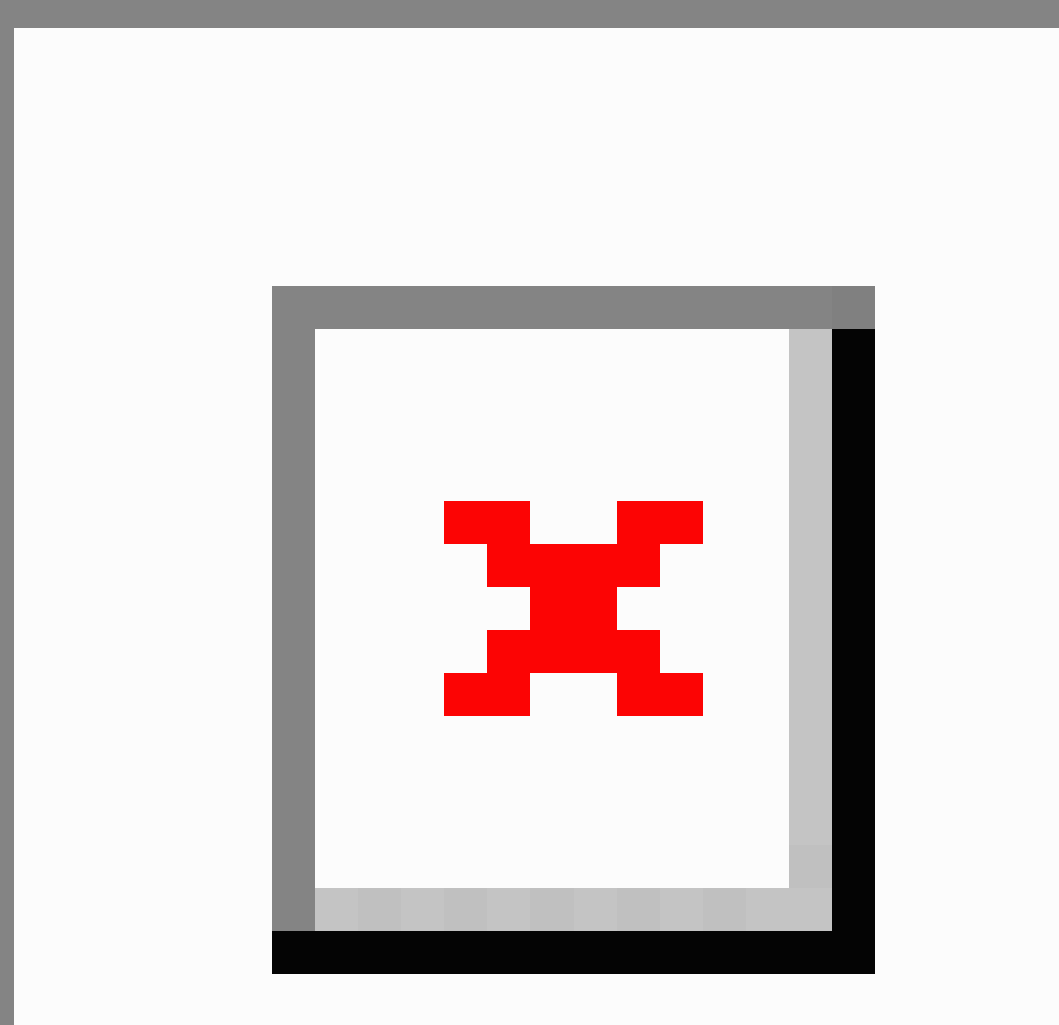
Figure 3. (a) The old interface showing the system status. Experts did not like the dull colors and crowded interface. Some users did not like the fact that there was no change of colors to indicate low battery, weak signal etc; (b) The updated interface with color indicators for connection, signal strength, and battery life, as well as increased text size and